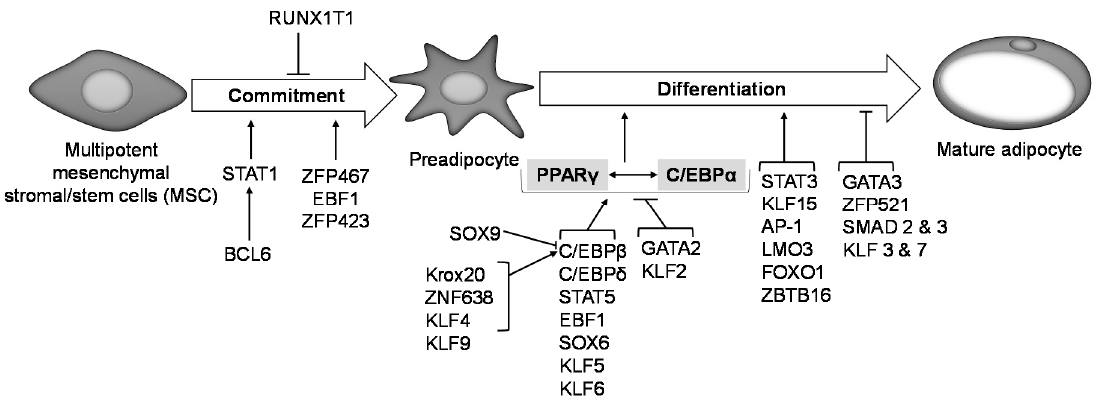
Figure 2. Transcriptional regulation of adipogenesis. Transcription factors Zfp423, Zfp467, EBF1 and BCL6 promote preadipocyte commitment into the adipogenic lineage, while RUNX1T1 inhibits this process. Expression of PPAR γ and C/EBP α is central to preadipocyte commitment and terminal differentiation, and several other transcription factors are known to regulate PPAR γ and C/EBP α expression downstream. Activation of either PPAR γ or C/EBP α transactivates the other. Krox20, ZNF638, KLF 4 and 9 activate C/EBP β expression, which in turn activates PPAR γ and thus promotes adipogenesis. SOX9 on the other hand binds to and suppresses C/EBP β promoter activity and inhibits adipogenesis. KLF 5, 6 and 9, SOX6, EBF1, STAT5, C/EBP δ activate PPAR γ expression thereby promoting adipogenesis. GATA2 and KLF2 inhibit PPAR γ activation and suppress adipogenesis. STAT3, KLF15, AP-1, LMO3, FOXO1 and ZBTB16 are other transcription factors are reported to promote preadipocyte differentiation, while GATA3, ZFP521, SMAD 2 and 3, KLF 3 and 7 are reported to suppress it.